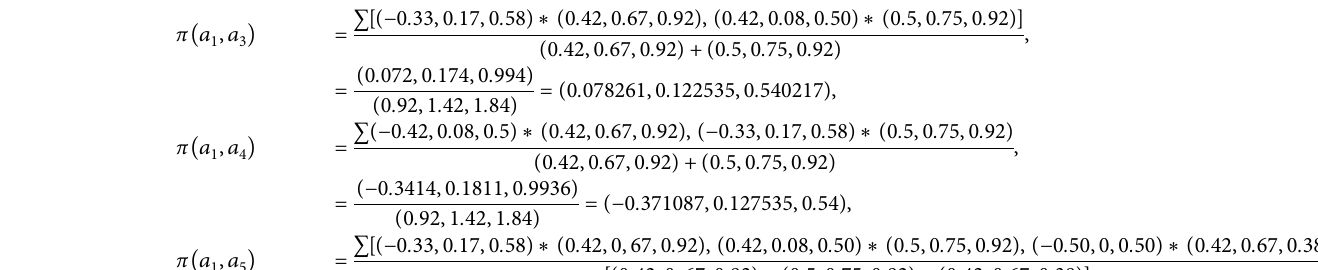
Table 10: Fuzzy preference function, 􏽥 P